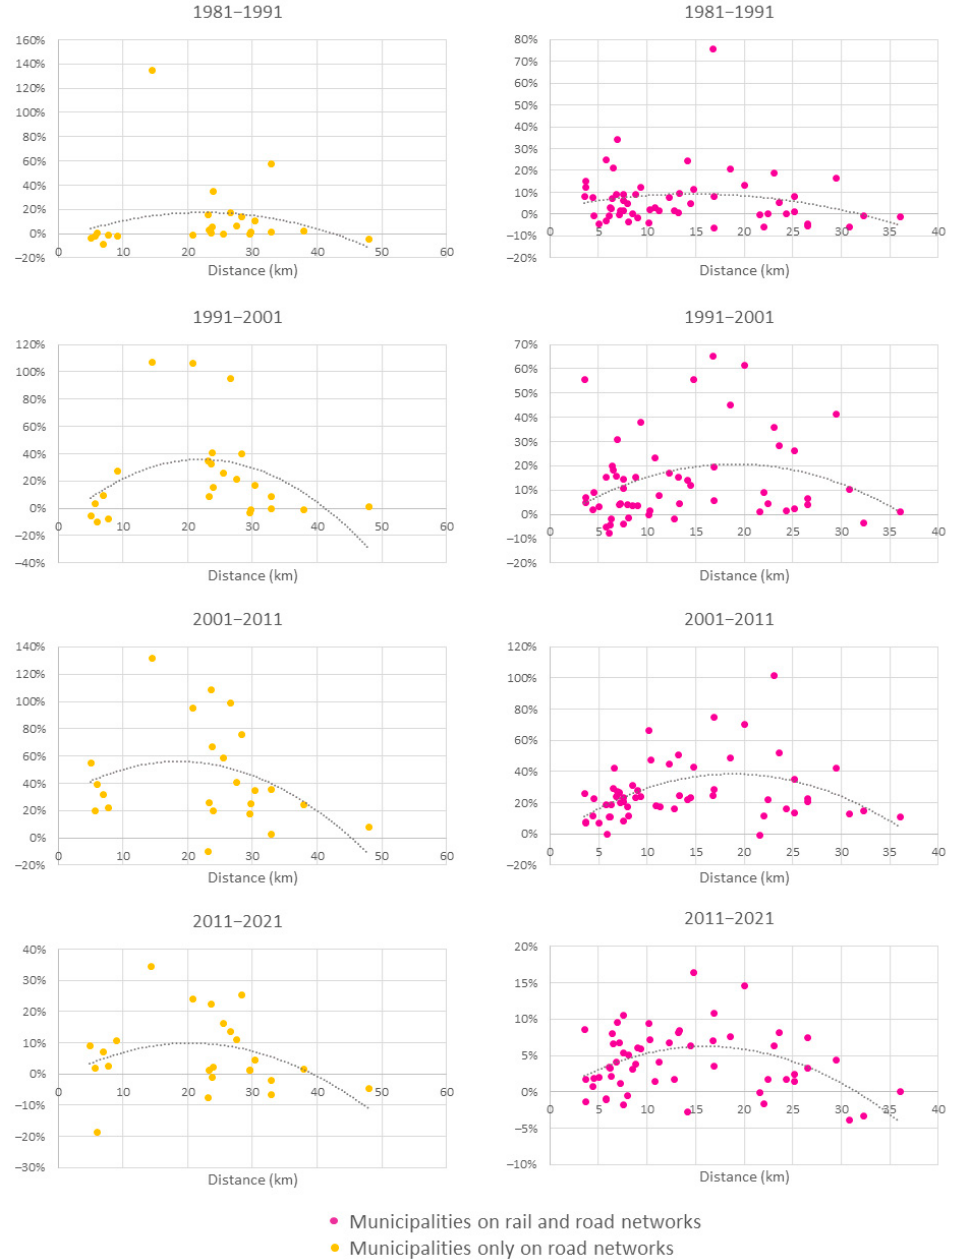
Figure 9. Relationship between population growth and distance to the centre in municipalities with and without a rail transport service, 1981–2021.